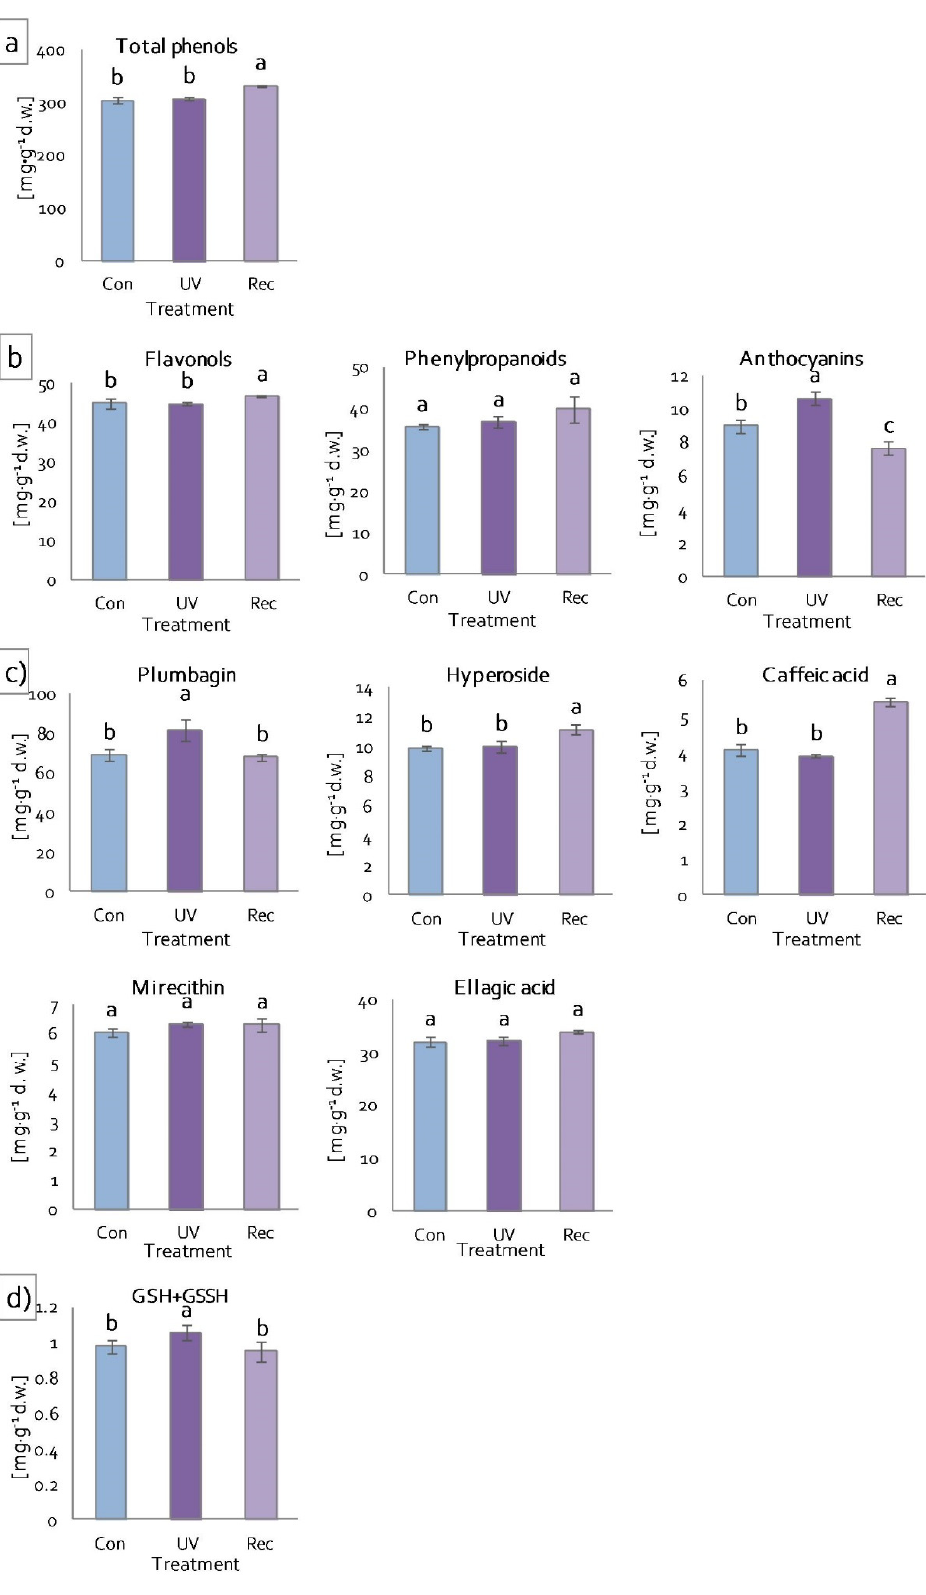
Figure 8. Content of low-molecular-weight antioxidants of D. muscipula leaves under UV-A treatment: ( a ) total phenolic compound; ( b ) phenolic compound group; ( c ) specific phenolic compound; ( d ) total glutathione; Con—control plants; UV—UV plants; Rec—recovery plants; different letters— statistically significant differences at p ≤ 0.05; n =